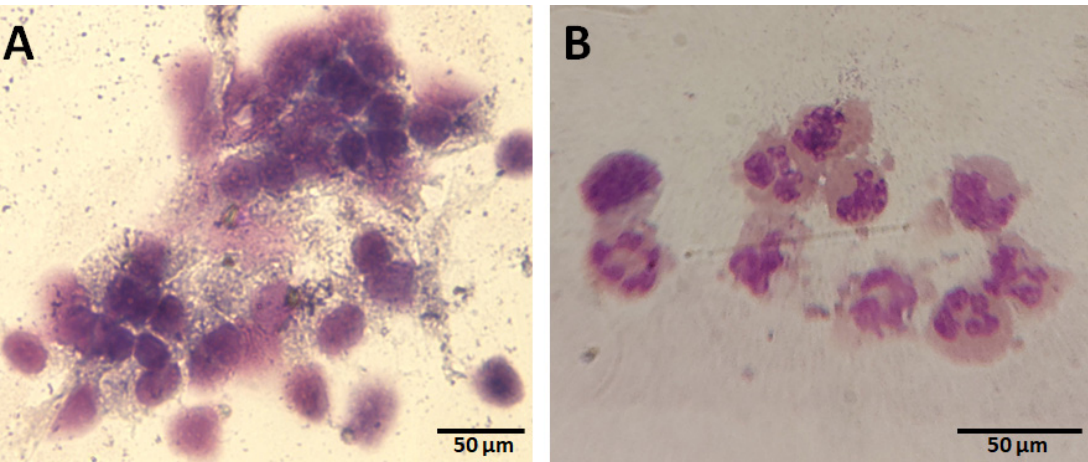
Figure 1. Representative images of cytological assessment by May–Grünwald/Gimsa staining of uterine cell smears in endometritis negative ( A ) and positive ( B ) mares.